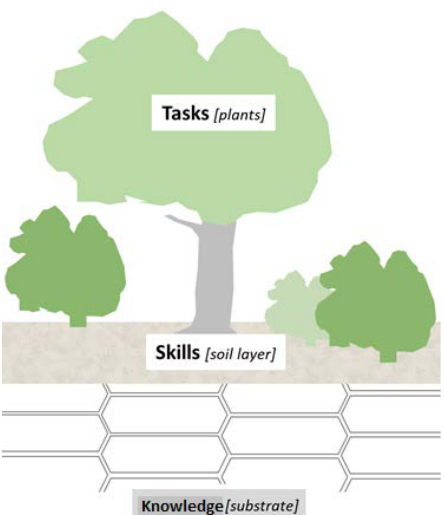
Figure 3. Completing the EO4GEO BoK with business-oriented knowledge and skills (Source: Hofer et al. 2020b, modified)